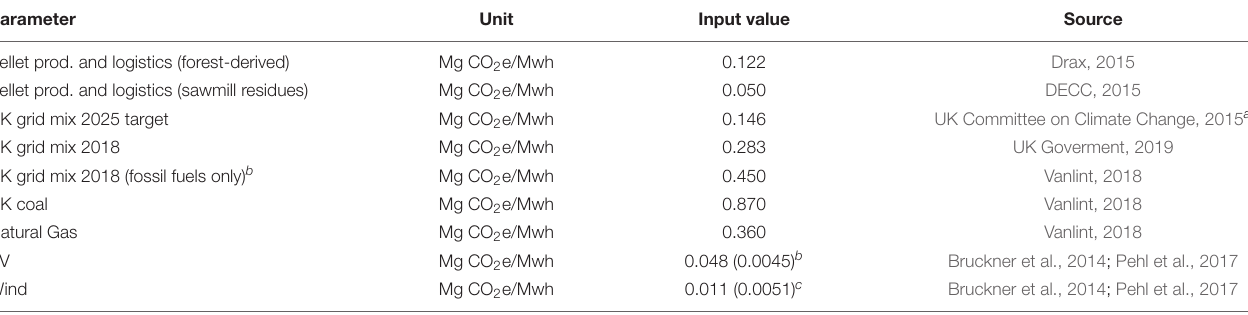
TABLE 2 | Selected electricity (grid) emission profiles with relevance to the UK. Parameter Unit